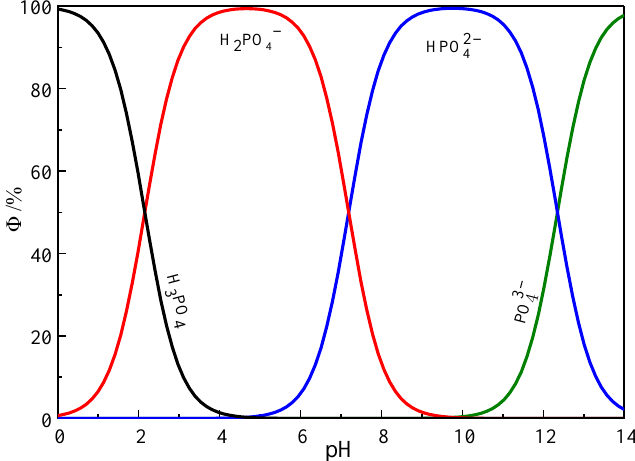
Figure 10. Distribution map of hydrolysis components of SHMP.